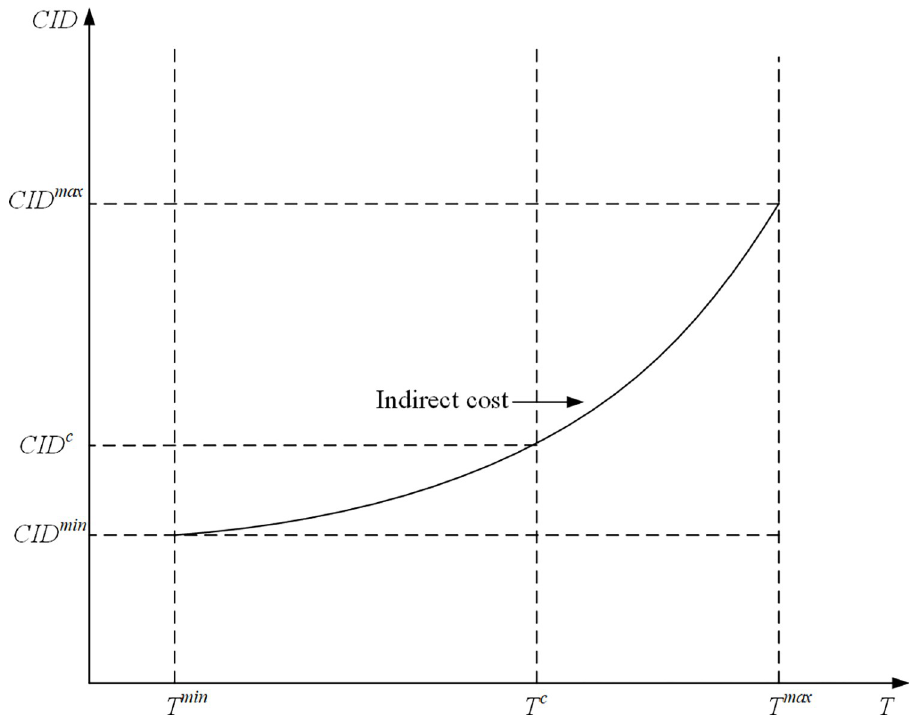
Fig 7. The curve of the relationship of time- indirect cost.